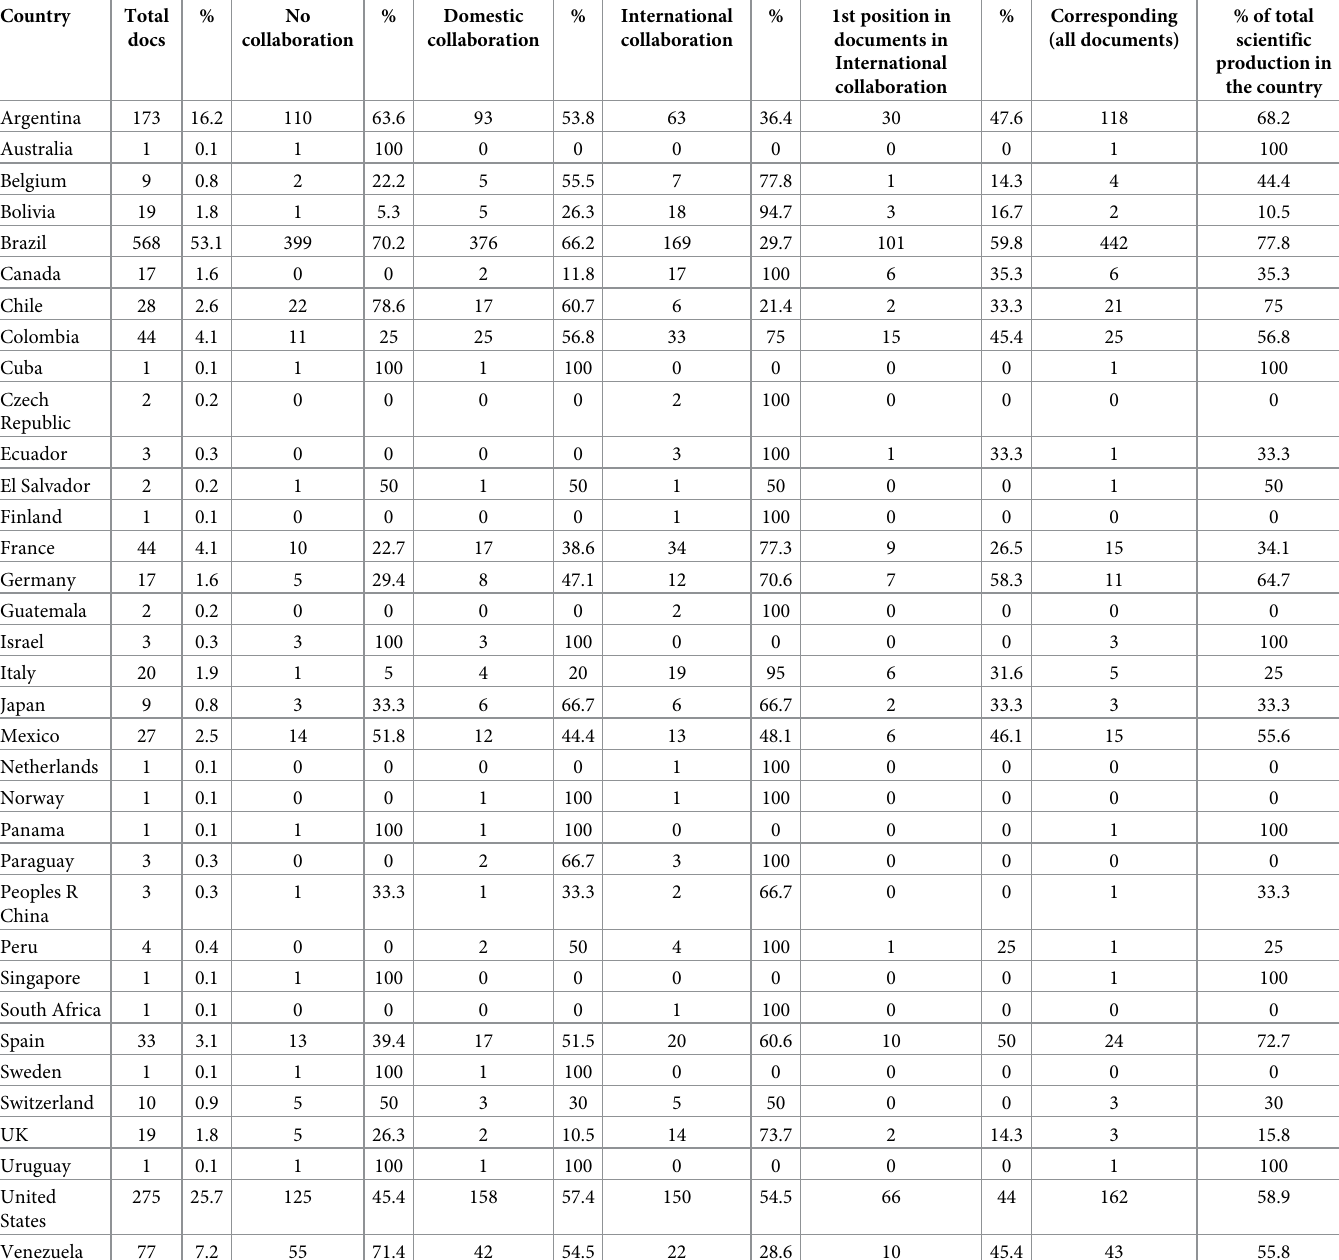
Table 6. Analysis of collaboration and leadership at country level in research production on Chagas